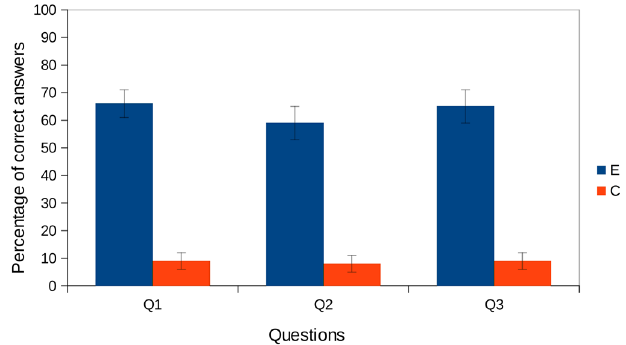
FIG. 1. Percentage of correct answers given to each of the questions by the 74 experimental students (E) and the 67 control students